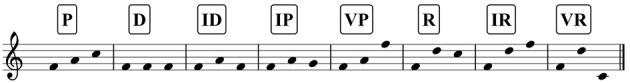
Basic Narmour structures P, D, R, and ID, and their derivatives VR, IR, VP, and IP.